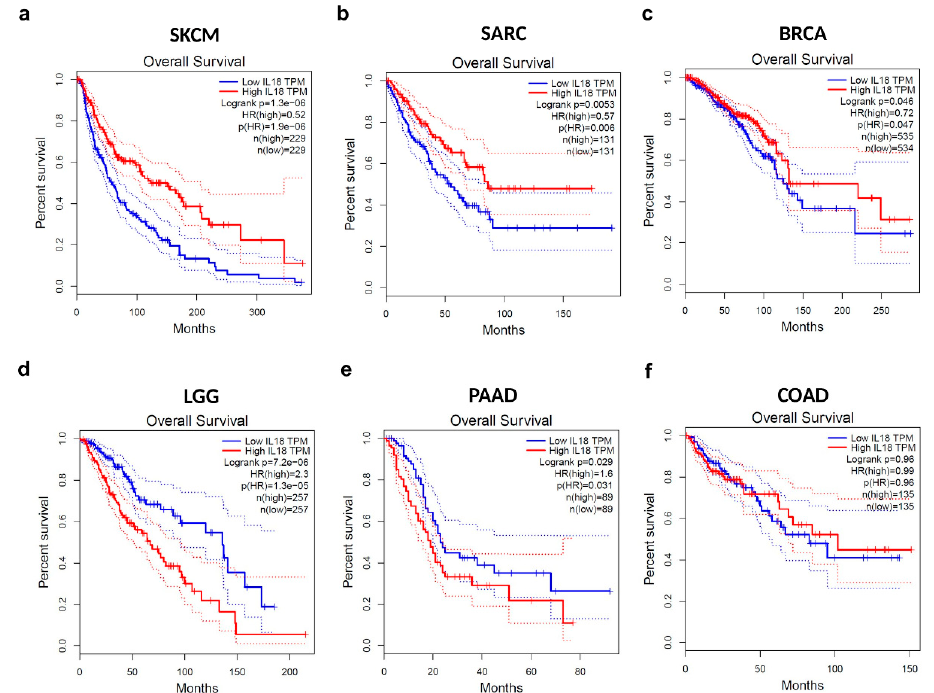
Figure 2. Correlation between IL18 expression and overall patient survival in various types of cancers. Kaplan–Meier survival curves with higher (red) and lower (blue) IL18 expression than the median were generated from TCGA data using the GEPIA website for ( a ) skin cutaneous melanoma (SKCM; n = 458), ( b ) sarcoma (SARC; n = 262), ( c ) breast invasive carcinoma (BRCA; n = 1069), ( d ) brain lower grade glioma (LGG; n = 514), ( e ) pancreatic adenocarcinoma (PAAD; n = 178), and ( f ) colon adenocarcinoma (COAD; n = 270). The log-rank P -value, Cox proportional hazard ratio (HR), P -value of HR, and number of patients in each analysis group are included. The 95% confidence interval is plotted with a dotted line. TPM—transcript per million.